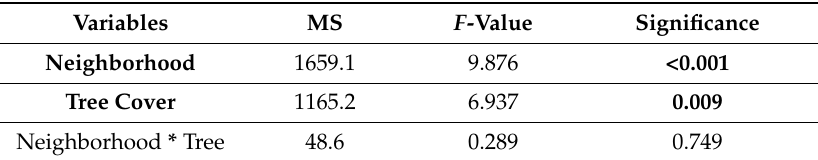
Table 7. Two-way ANOVA for mean relative humidity at 1500 LDT for the warm season based on neighborhood classification and tree density, including mean-square error (MS), F value, and significance. Bold variables are significant ( p < 0.05).